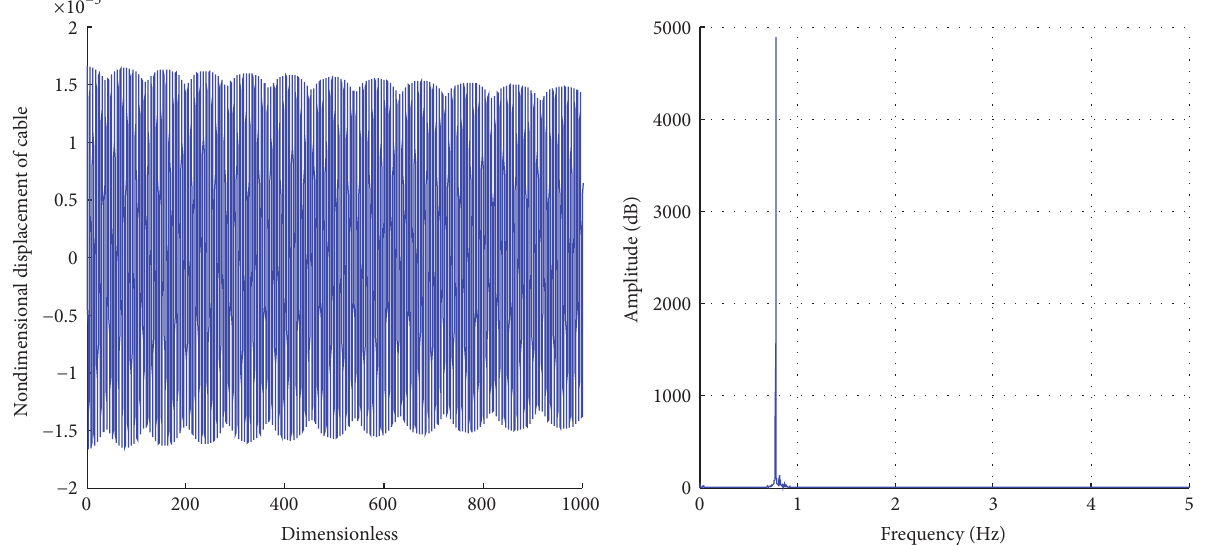
Figure 5: Dimensionless displacement response time history and amplitude-frequency characteristic curve of the deck beam end.